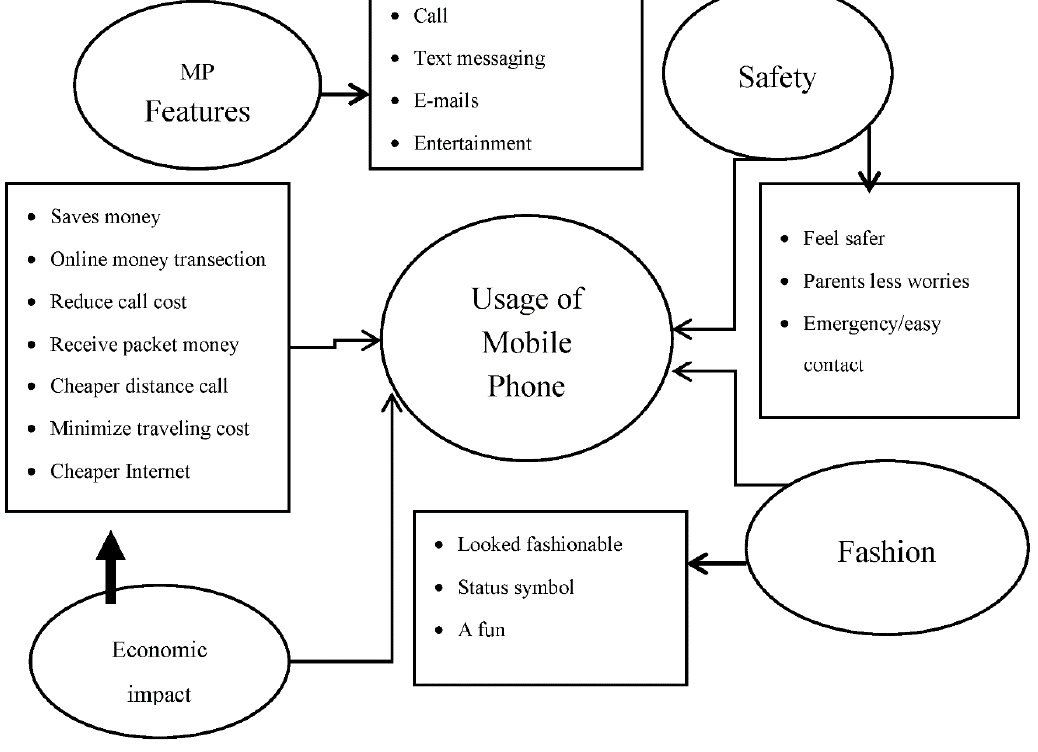
Figure 1. Theoretical framework.